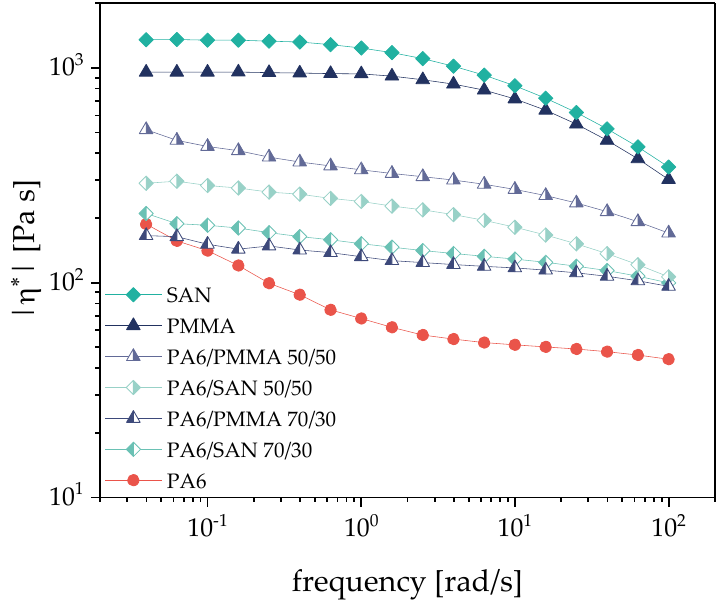
Figure 2. Complex viscosity |η*| of the blend components and selected unfilled blends at 240 °C. Interestingly, the 50/50 wt.% blends show higher values for the blend with PMMA compared with SAN, whereas in blends with 30 wt.% of the second component the blends with SAN shows higher values than that with PMMA. The viscosity values are between those of the components (Figure 2). Based on the general tendency that the phase inver- sion concentration in blends depends on the viscosity ratio and the lower viscosity com- ponents tends to form the matrix in immiscible blends, these viscosity relationships sug- gest that PA6 has the tendency to form the continuous component even at lower contents than 50 vol.% (53.3 wt.% with SAN, 50.5 wt.% with PMMA) if no SWCNTs are added. However, the blends under investigation here contain SWCNTs that are expected to reinforce the PA6 component of the blend. Comparing the viscosity curves of pure PA6 and that of PA6 filled with 3 wt.% SWCNTs (Figure 3), a dramatic increase in melt viscos- ity is seen especially at low measurement frequencies, and the filled PA6 exceeds the vis- cosity values of pure SAN and PMMA. Thus, in the filled blends the viscosity ratios be- tween PA6 with 3 wt.% filler and the second polymer get values larger than one. With viscosity ratios at 100 rad/s of 2.34 for SAN and 2.68 for PMMA as blend partners it is expected that SAN and PMMA tend to form the matrix even at higher PA6 contents than 50 vol.%. Based on the Tailor equation [60,61] it may be also expected that due to the higher viscosity ratio, the matrix-droplet morphologies of the PA6/PMMA blends will have smaller particle sizes than the blends with SAN assuming comparable interfacial tension and shear conditions.